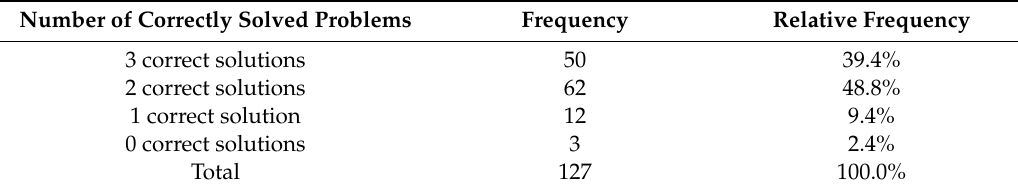
Table 1. Frequencies of correctly solved problems in one test (source: own calculation).